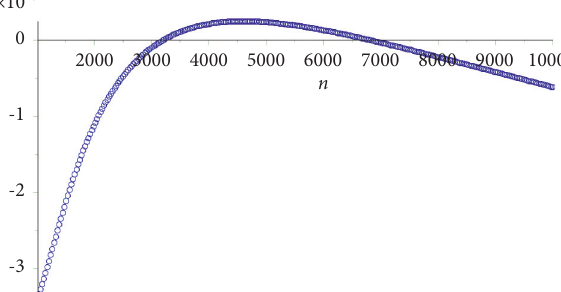
Figure 20: The relative error of I Table 8: The relative error of I